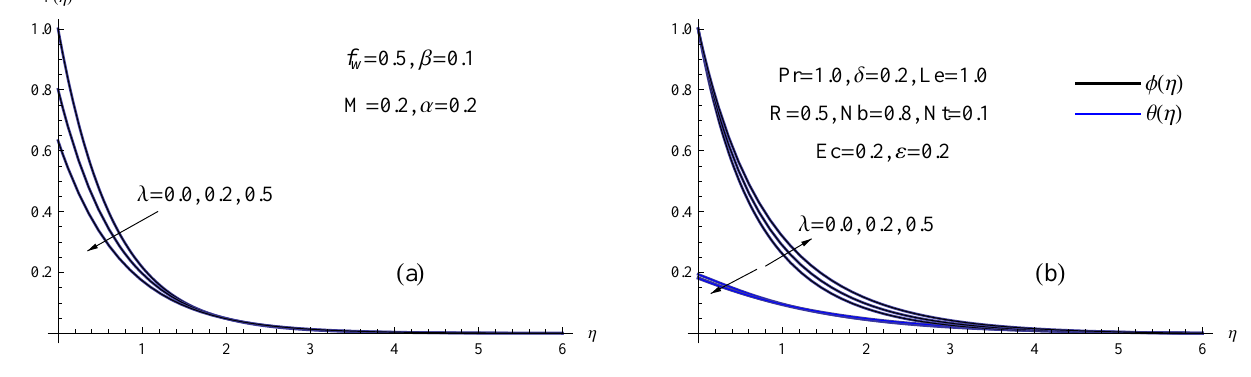
mensionless variable η . Additionally, we see that the velocity distribution changes as η is increased in the interval 0 ≤ λ < 2. Further, when the slip velocity parameter λ improves, the same drop tendency is shown for both the temperature distribution θ ( η ) and the sheet temperature θ ( 0 ) . Moreover, we can see from the following graphic that with rising values of λ , the boundary layer thickness and the concentration field both get better.